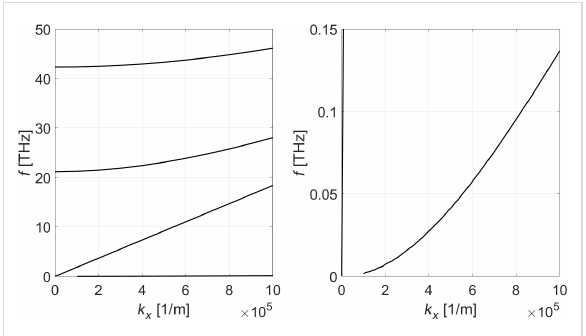
Figure 2: Dispersion relations for the coupled u x – u z acoustic phonon modes of single-layer graphene. The right plot is a zoomed version of the left plot. Note the nonlinear dispersion of one acoustic mode away from the Γ point. There is also one acoustic mode showing linear dispersion.